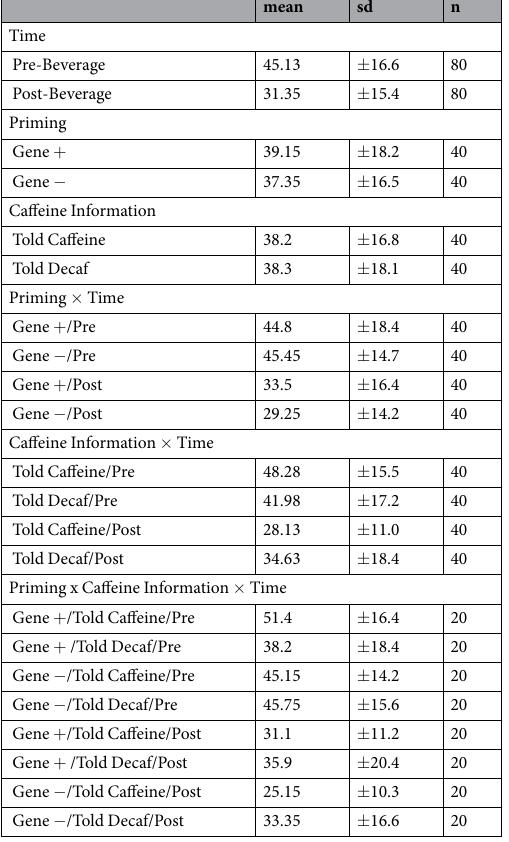
Table 1. Descriptive Statistics for Caffeine Withdrawal Across Time Points and Groups.